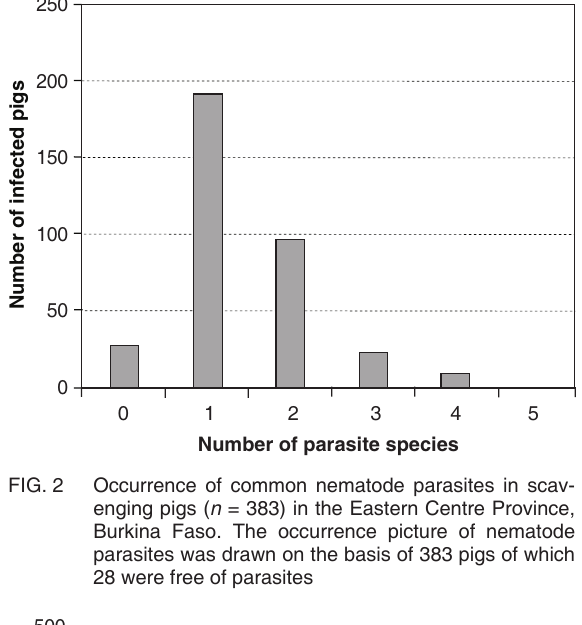
FIG. 2 Occurrence of common nematode parasites in scav- enging pigs ( n = 383) in the Eastern Centre Province, Burkina Faso. The occurrence picture of nematode parasites was drawn on the basis of 383 pigs of which 28 were free of parasites